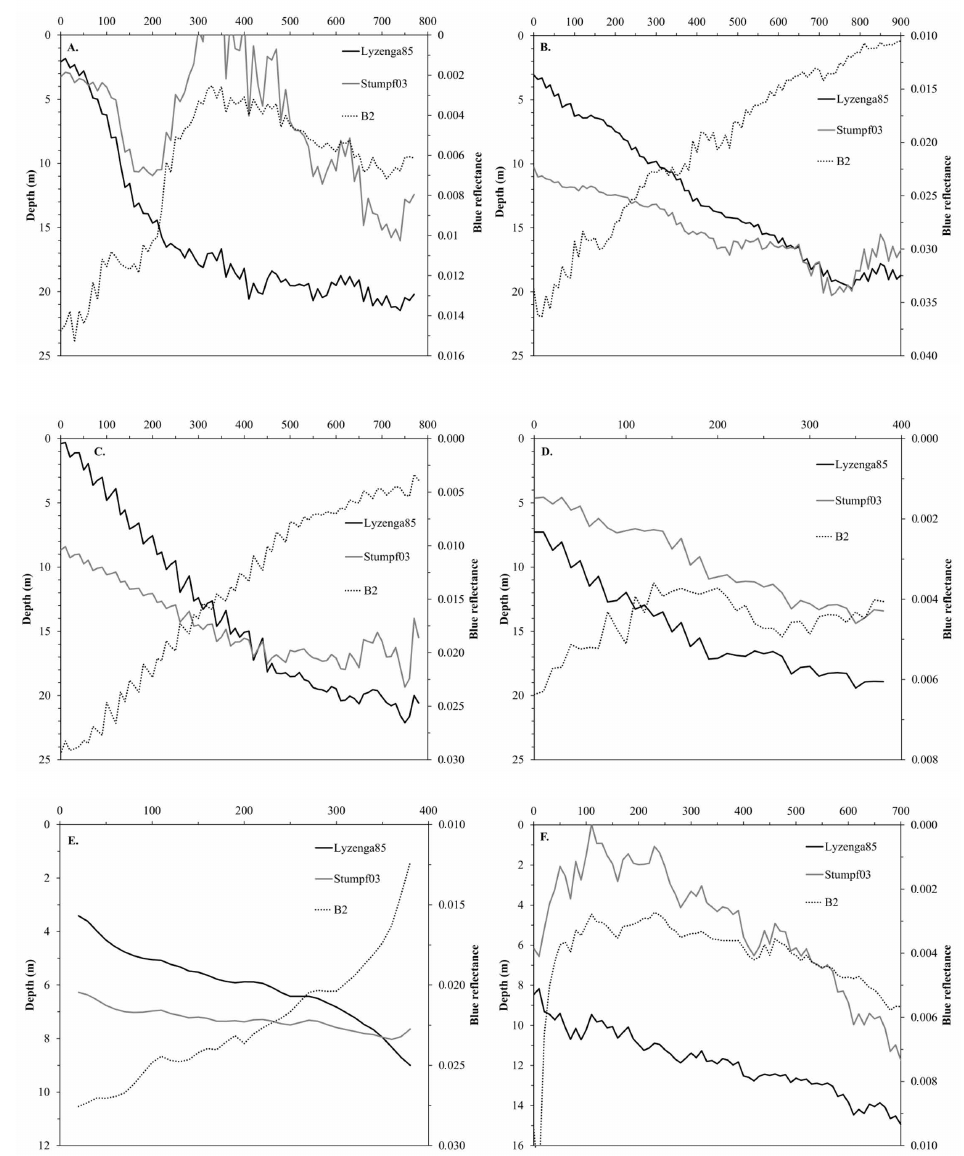
Figure 8. Satellite-derived bathymetry profiles using most accurate Lyzenga85 and modified Stumpf03 models, and a 3 × 3 smoothed and normalised median blue Sentinel-2 reflectance composite (490 nm). ( A ) Samaria National Park: profile over seabed with rocks, sand, and Posidonia oceanica seagrass, successively; ( B ) Samaria National Park: profile over sand; ( C , D ) the Apokoronas site: profiles over sand and algae-covered beds, respectively; ( E , F ) Thermaikos site: profiles over sand and P. oceanica seagrass,